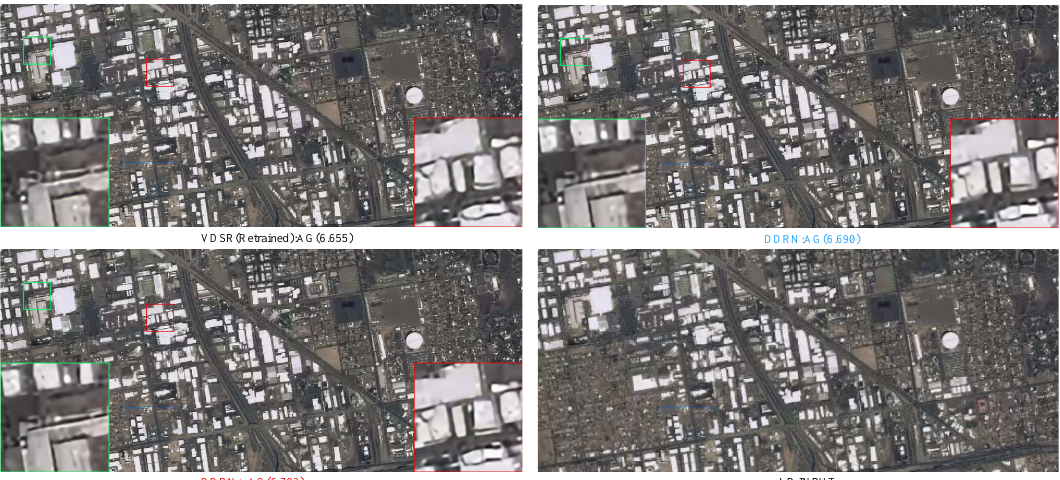
Figure 11. An example for the reconstruction results on Jilin-1 imagery by the scale of 4. The experiment is performed with real low satellite images rather than simulation degradation. Red and blue respectively indicate the first and the second best performance in terms of AG. Note that the enlarged details are shown in the boxes on the bottom left and bottom right in each